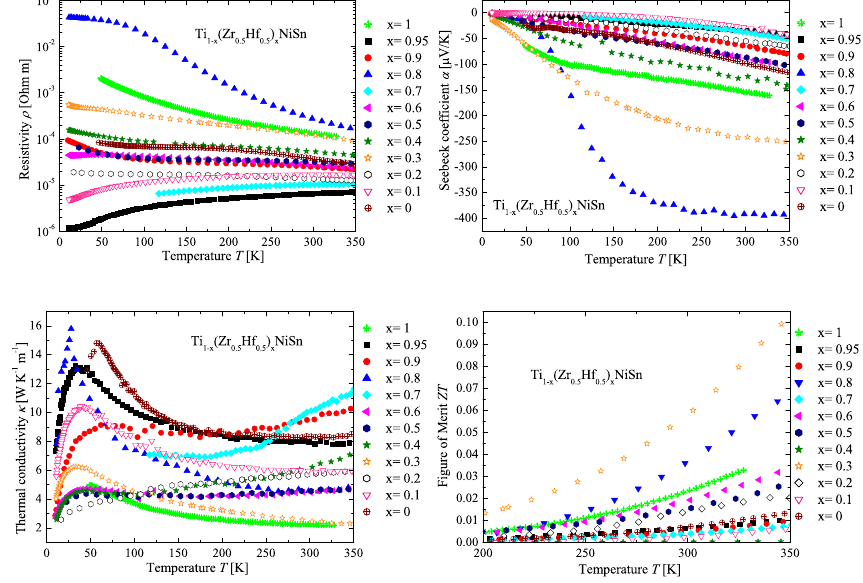
Figure 12. Electrical resistivity ( top left ), Seebeck coefficient ( top right ), thermal conductivity ( bottom left ) and figure of merit ( bottom right ) of the Ti ( 1 − x ) (Zr 0.5 Hf 0.5 ) x NiSn series in comparison to the parent